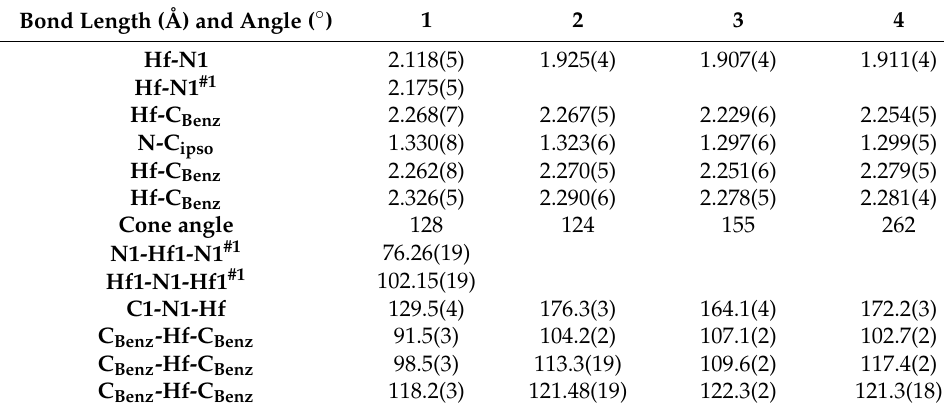
Table 1. Selected bond lengths (Å) and angles ( ◦ ) for 1 – 4 . Bond Length (Å) and Angle ( ◦